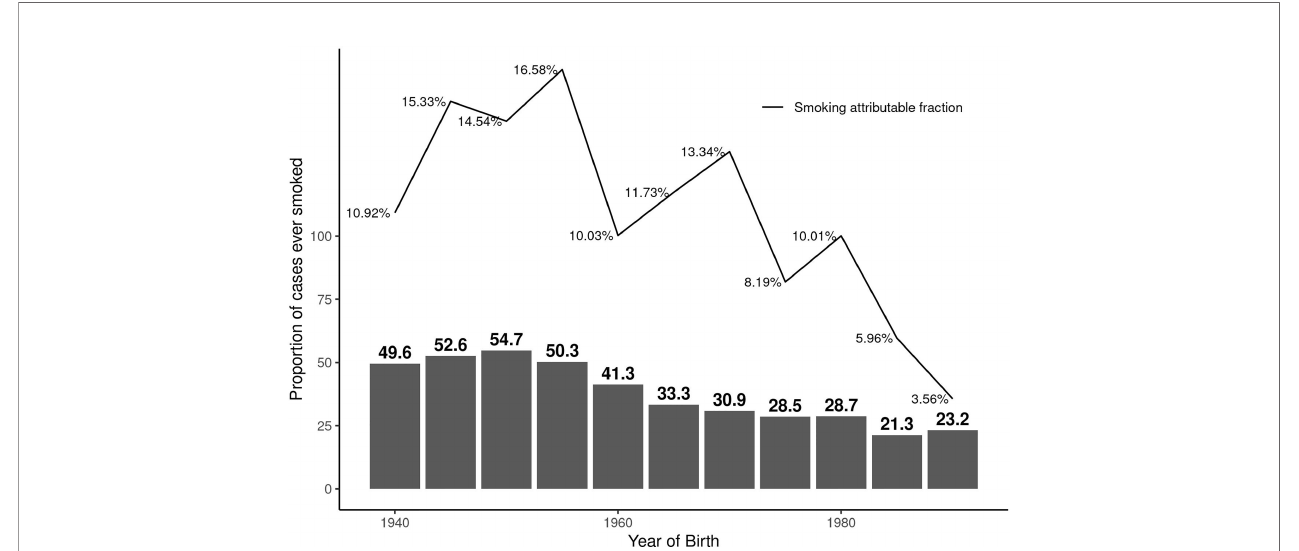
FIGURE 1 | Proportion of persons with MS who have ever regularly smoked and the corresponding smoking attributable fraction (AF) over calendar year of birth by fi ve-year birth-cohort.